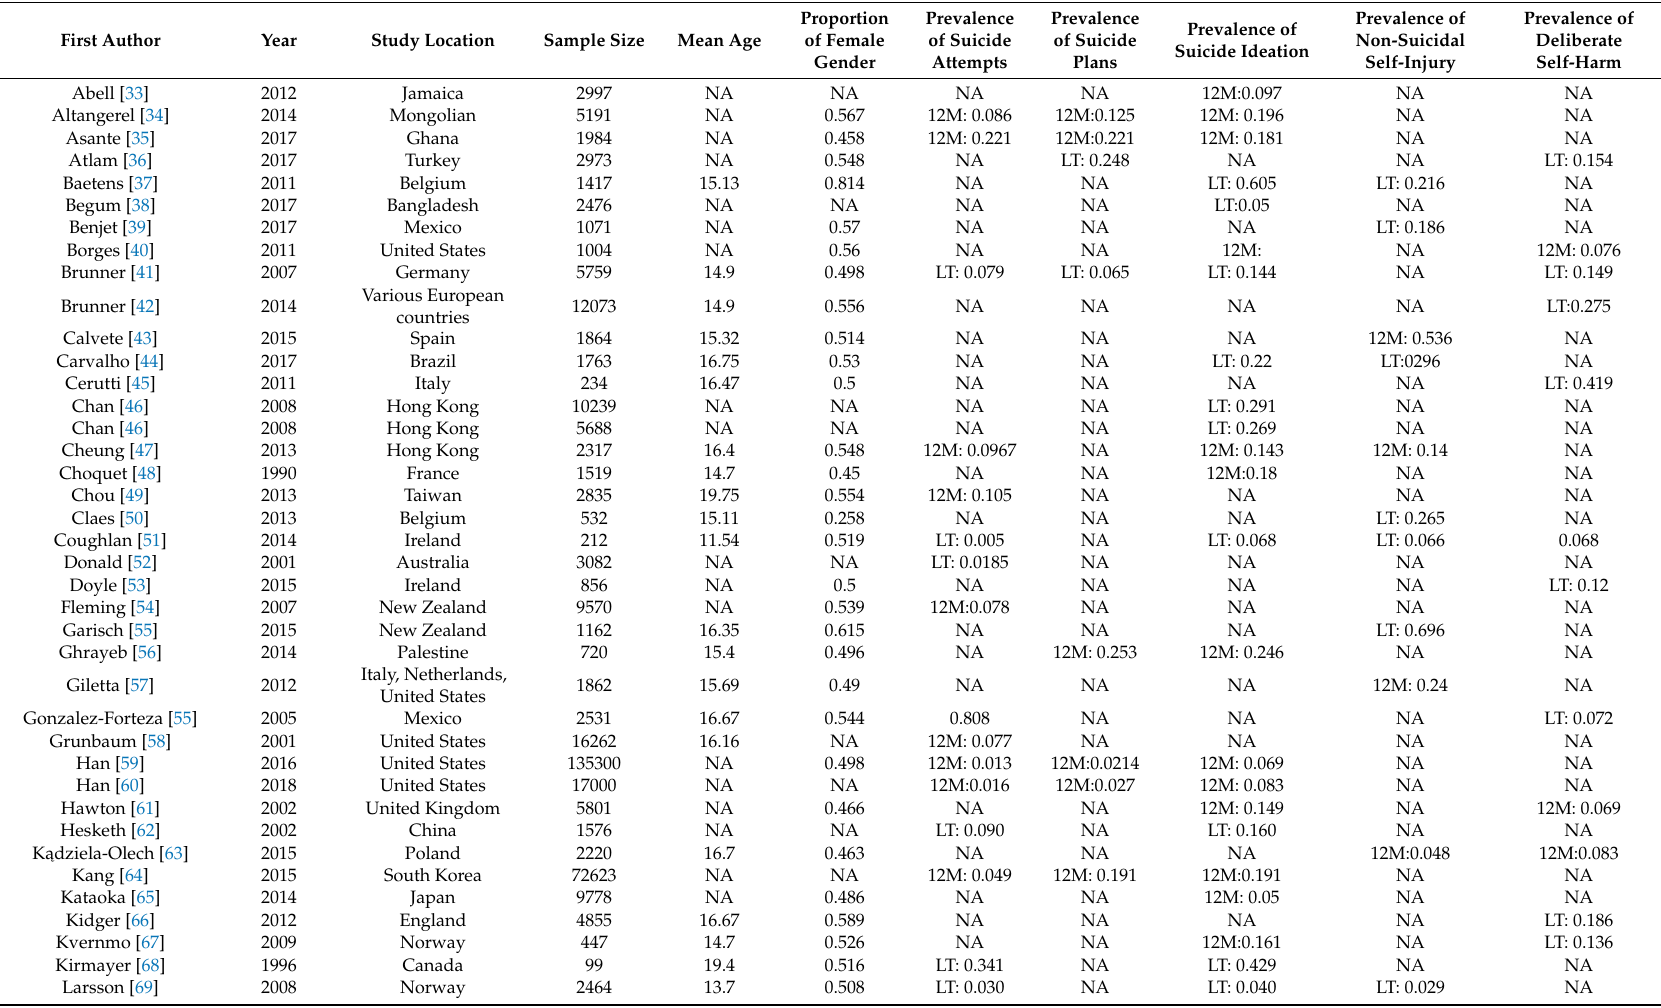
Table 1. Characteristics of the Studies Included in This